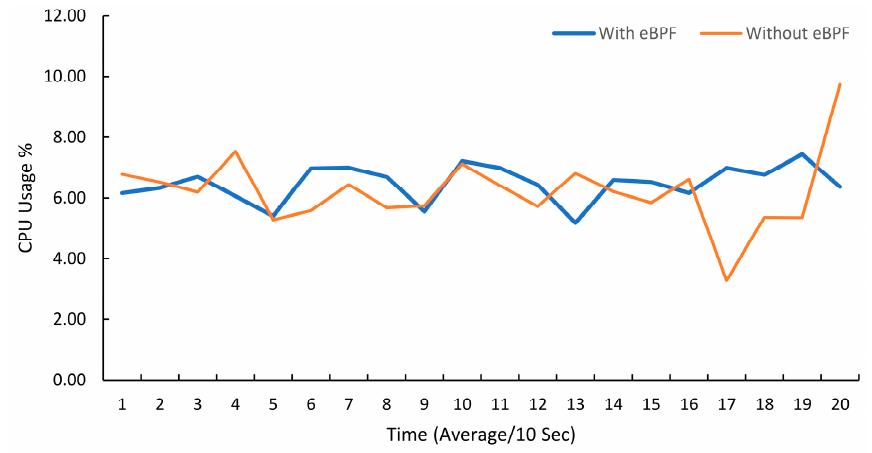
Figure 5. Worker Node CPU Overhead Analysis.